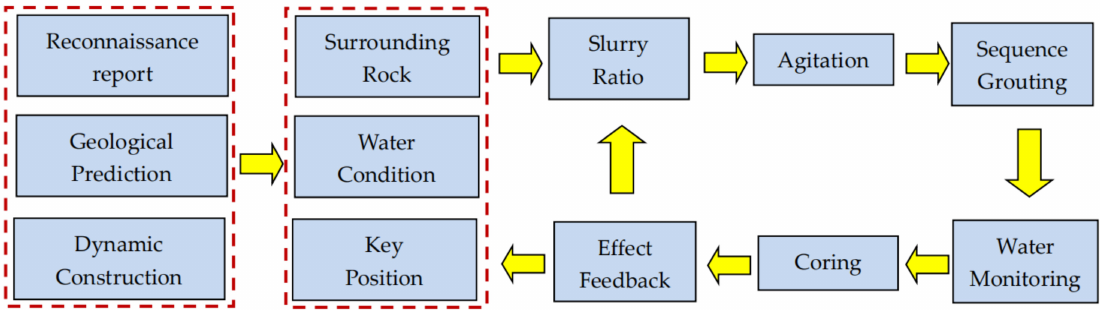
Figure 21. Grouting construction technology.